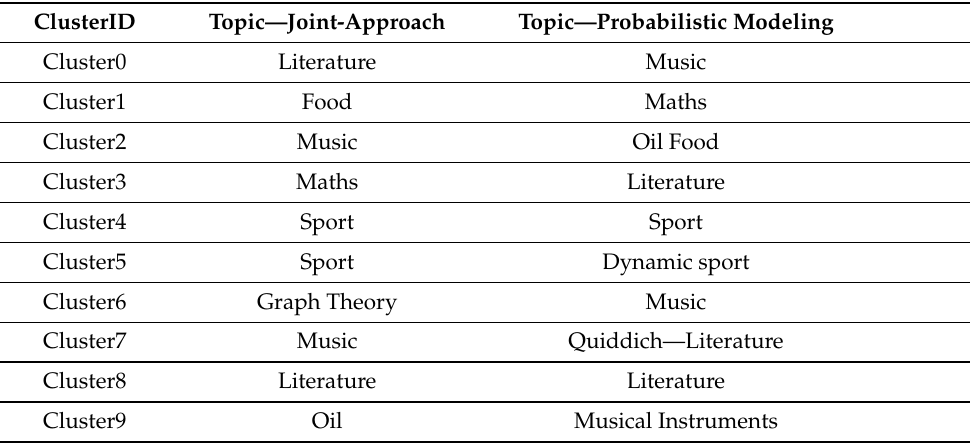
Figure 11. D1, word cloud representation, TF-IDF weighting scheme for joint-approach. Table 17. Topic description for dataset D1 for both the